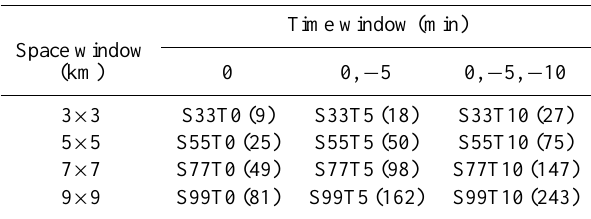
Table 2. WCMM scenariosanalyzed and the number of Z e values.